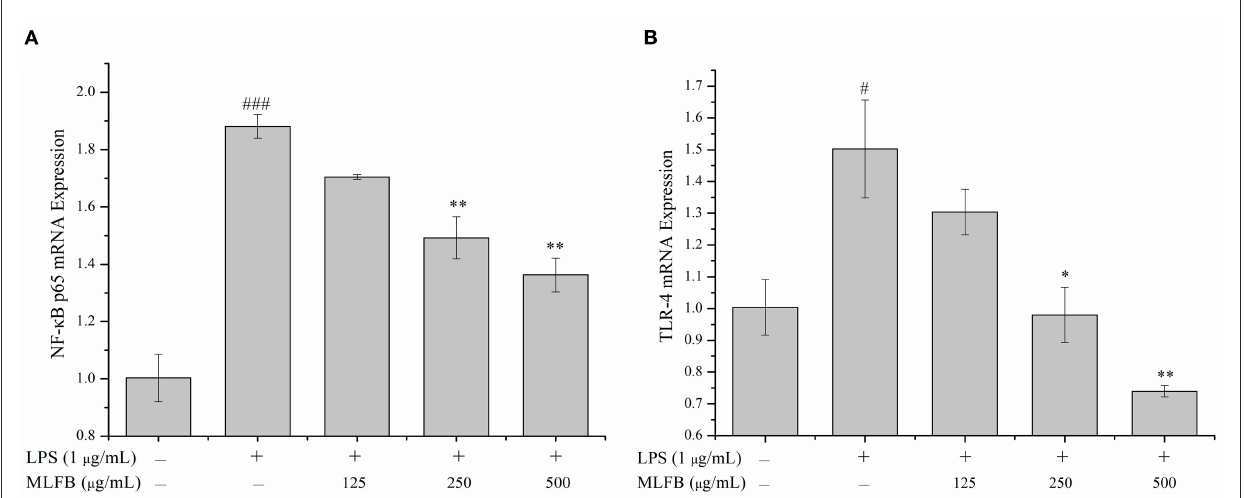
FIGURE6 Effects of MLFB on the mRNA expressions of NF- κ B p65 (A) and TLR-4 (B) in LPS-induced RAW 264.7 cells. # Means statistical difference compared with blank control group ( # P < 0.05, ### P < 0.001). *Means statistical difference compared with LPS-induced inflammatory model group (* P < 0.05, ** P < 0.01).